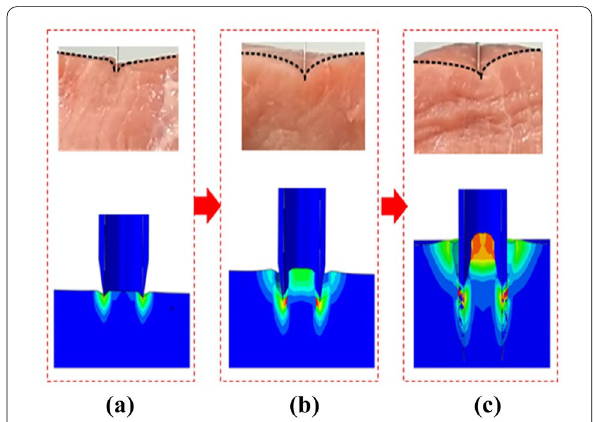
Figure 12 Variation of reaction force at the needle reference